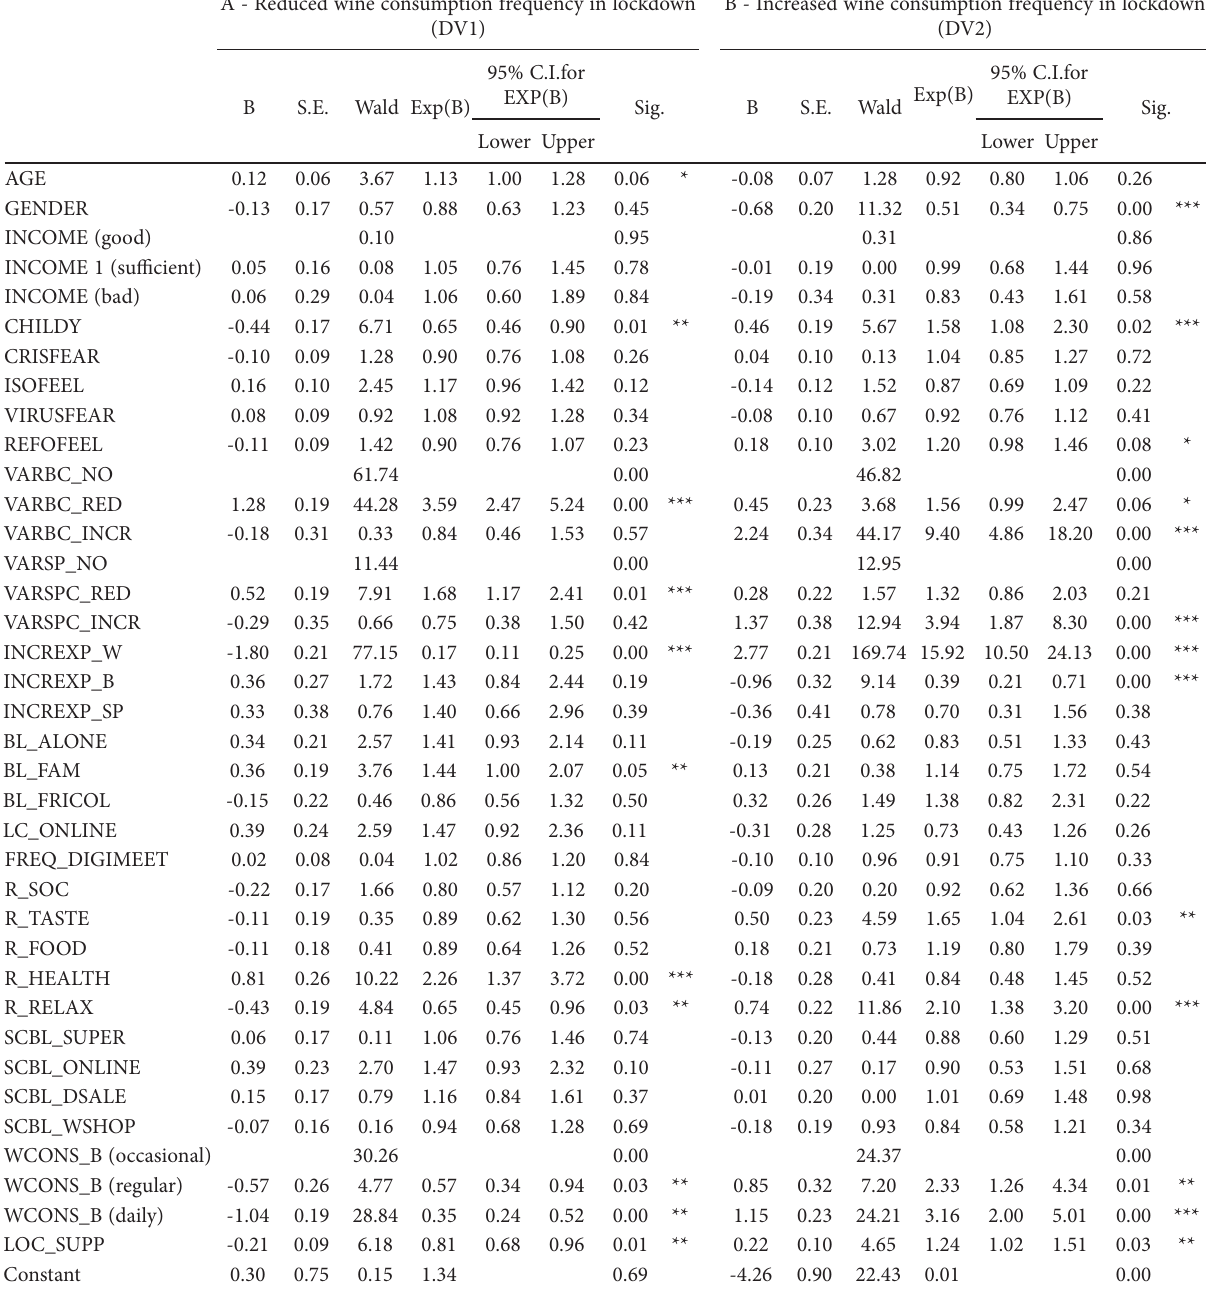
Table 5. LR on the decrease (DV1; Model A) and increase (DV2; Model B) of wine consumption frequency in lockdown. A - Reduced wine consumption frequency in